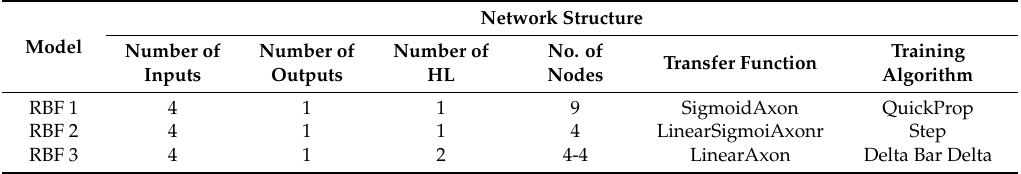
Table 10. The structure of different RBF models optimized with the GA.